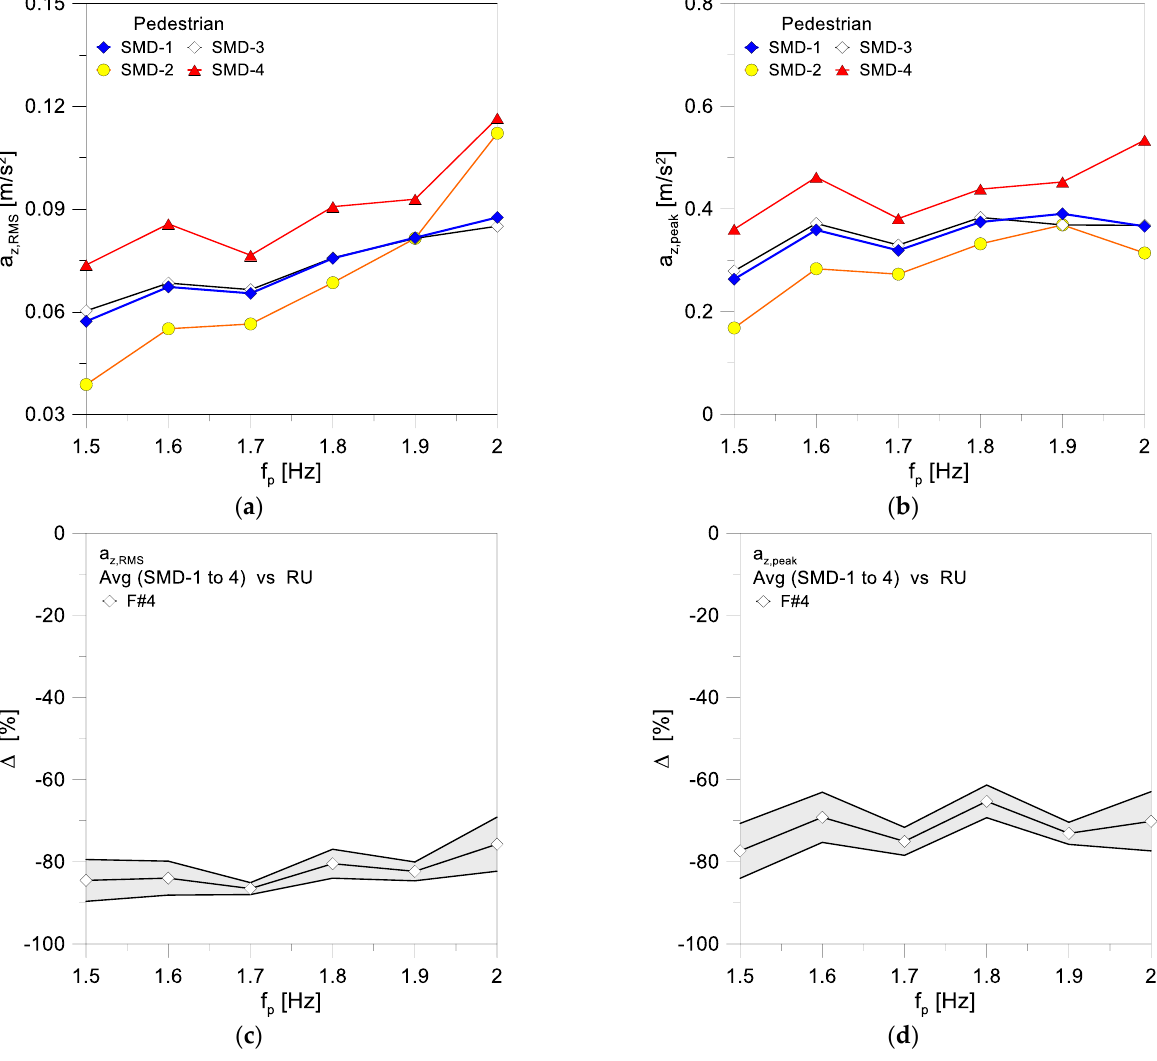
Figure 10. Numerical results for the glazed F#4 system, based on different SMD or equivalent-force calculations: ( a ) RMS acceleration and ( b ) peak acceleration, as a function of walking frequency f p , with ( c , d ) corresponding SMD (average ± standard deviation) to RU percentage scatter (ABAQUS).